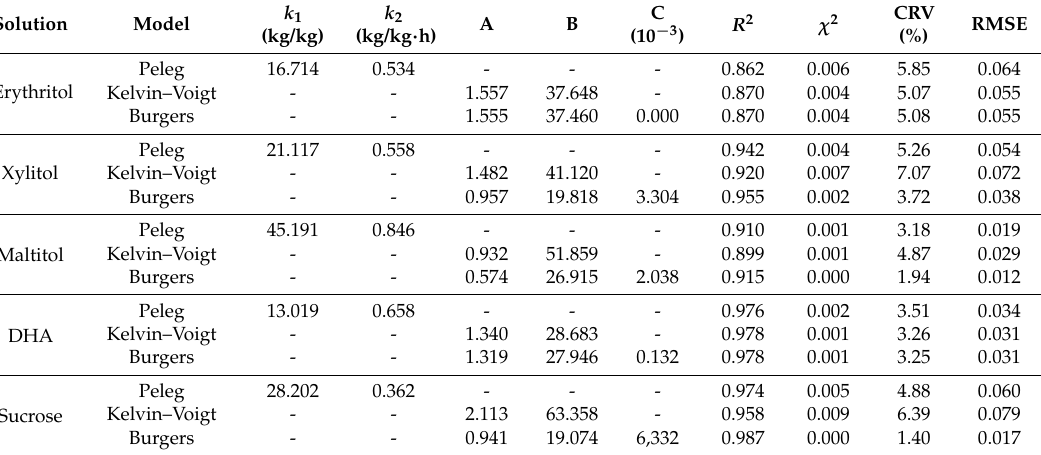
Table 4. The values of k 1 , k 2 , R 2 , χ 2 , CRV and RMSE of modeling WL using Peleg’s, Kelvin–Voigt and Burgers